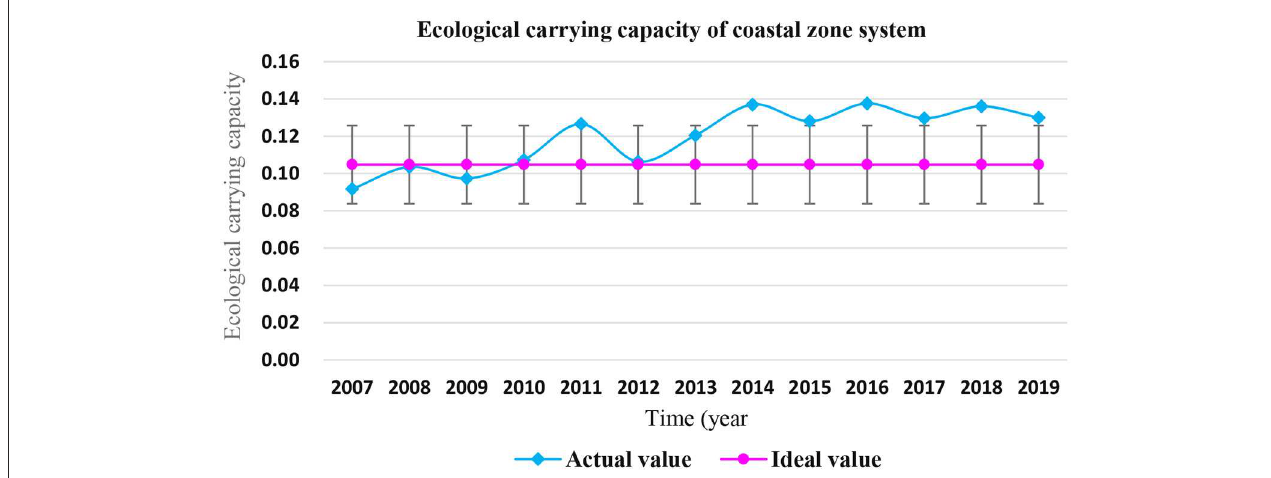
FIGURE10 Carrying capacity of coastal ecosystem in Shandong Province from 2007 to 2019.